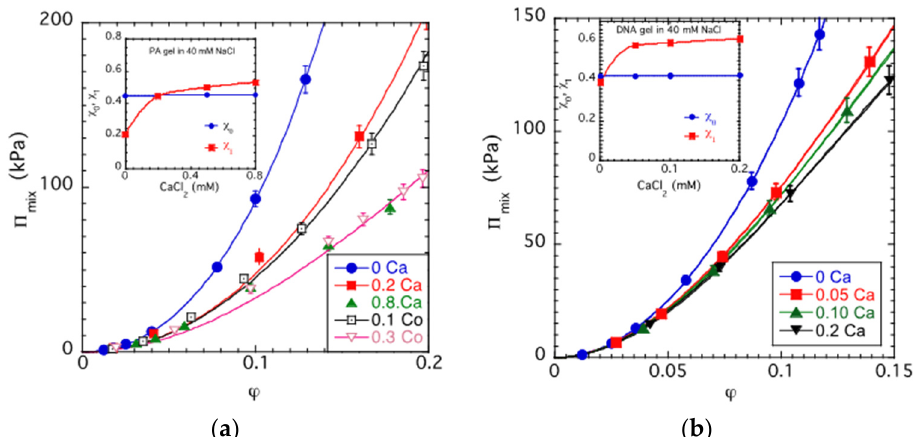
Figure 4. Mixing pressure, Π mix , vs. polymer volume fraction, ϕ plots for PA ( a ) and DNA gels ( b ) in different salt solutions. The continuous lines show the fits of Equation (4) to the experimental data. Insets: variation in χ and χ 1 as a function of the CaCl 2 concentration in PA and DNA gels swollen in 40 mM NaCl.